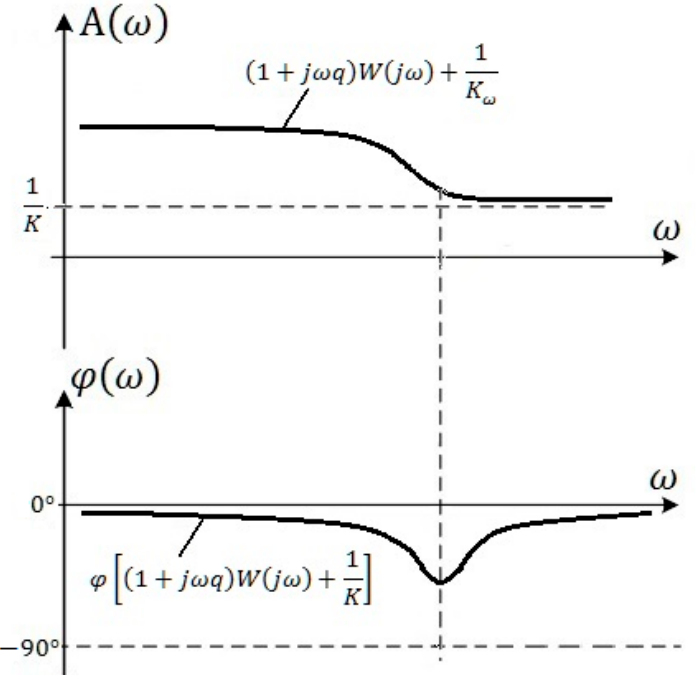
Figure 5. Stability condition according to V.M. Popov criterion is transferred on logarithmic frequency characteristics of ACS.